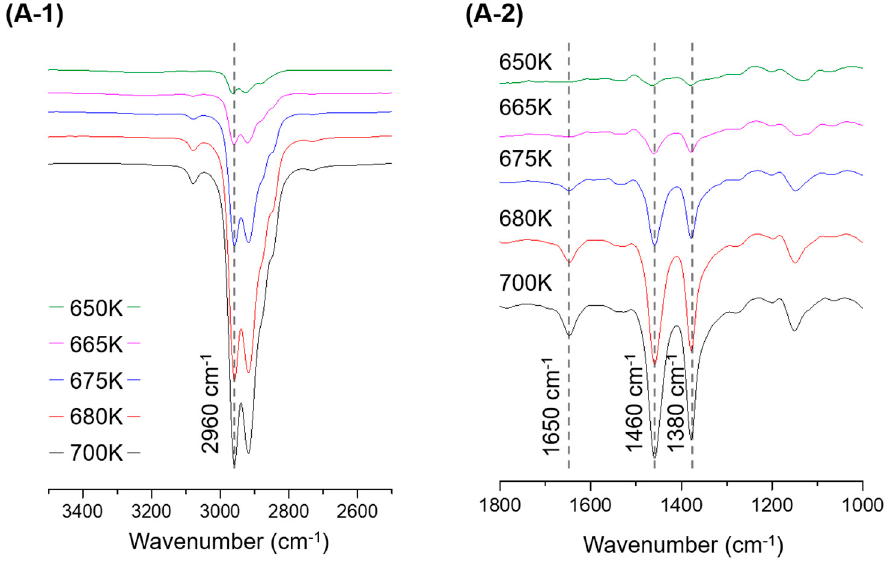
Figure 4. IR Spectrum drift at the end of PP pyrolysis. (A-1) 3400–2500 cm − 1, in the range of